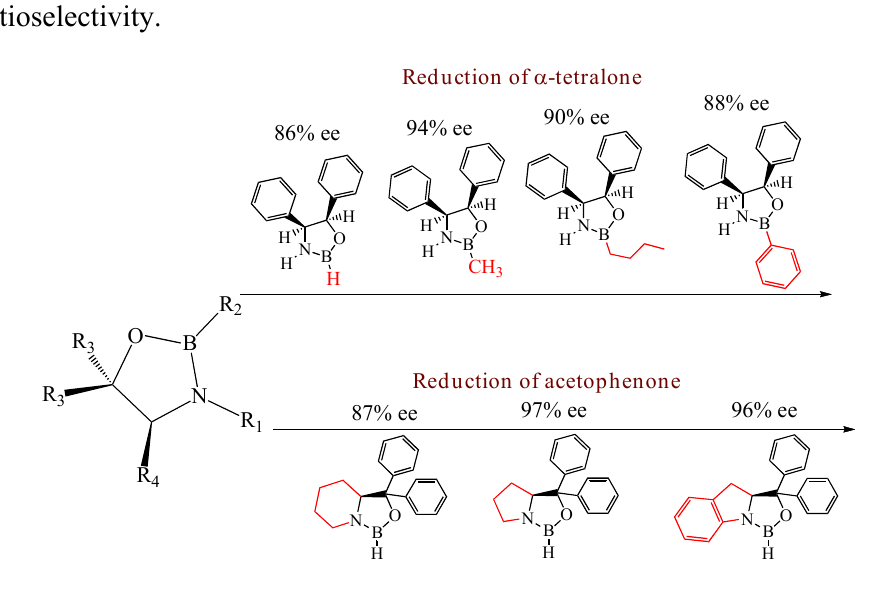
Figure 1. Influence of substituent linked to oxazaborolidine boron and nitrogen element on the enantioselectivity.